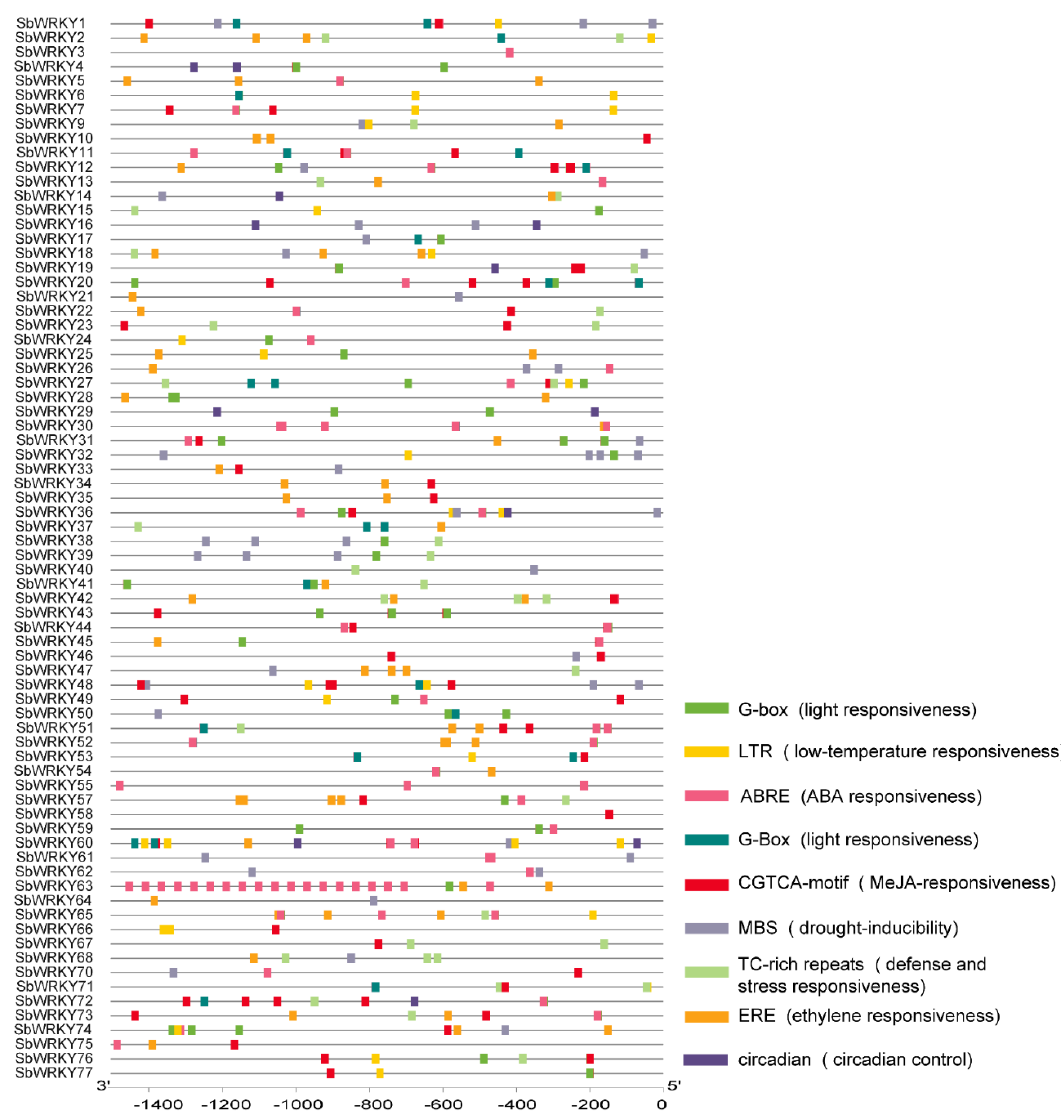
Figure 5. Predicted cis ‐ elements that relate to abiotic stress in the SbWRKY prompters. The distribution of cis ‐ elements in the 1500 bp upstream promoter regions of SbWRKY genes. Different cis ‐ elements are represented by different colors.